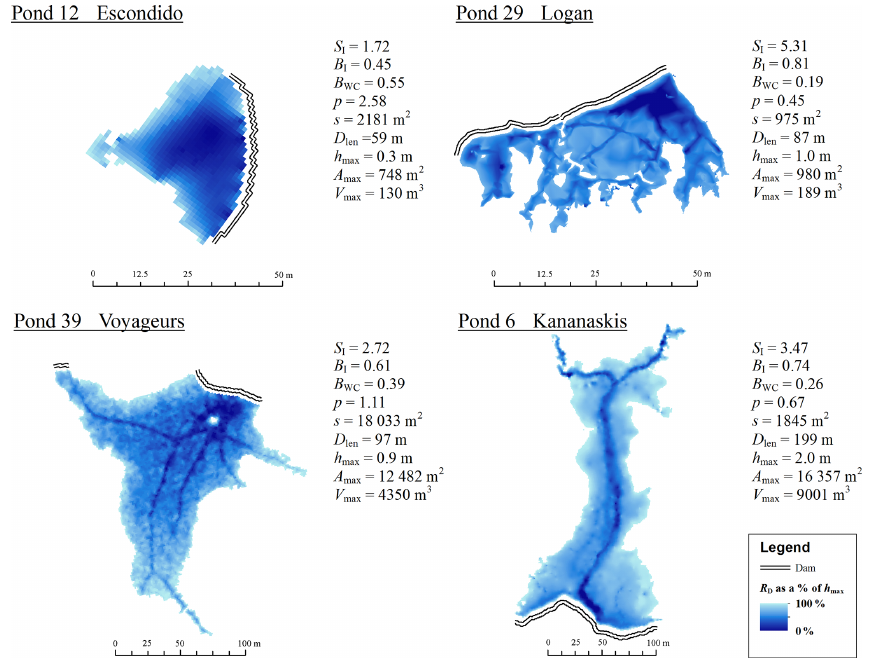
Figure 2. Four examples of detrended beaver pond DEMs used for this study, one from each study area ( S I = shape index, B I = bathymetric integral, B WC = bathymetric water capacity, p = morphometry coefficient (full model), s = scaling coefficient, D len = dam length, h max = maximum height of the dam, A max = maximum surface area of the pond, and V max = maximum volume of the